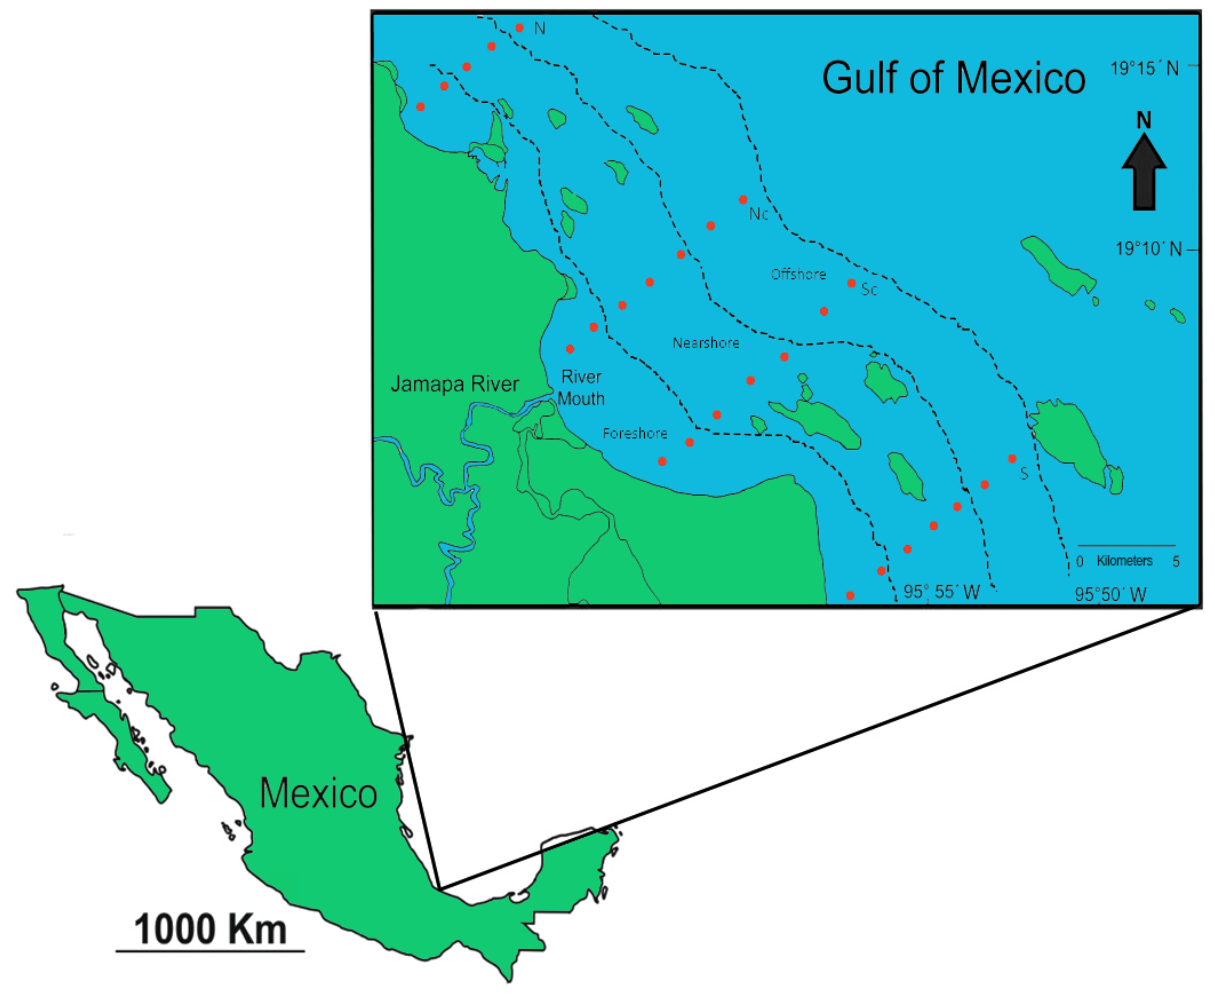
Figure 1. Location of the study area showing transects and sampling stations. N, Northern; Nc, North central; Sc, South Central; S,